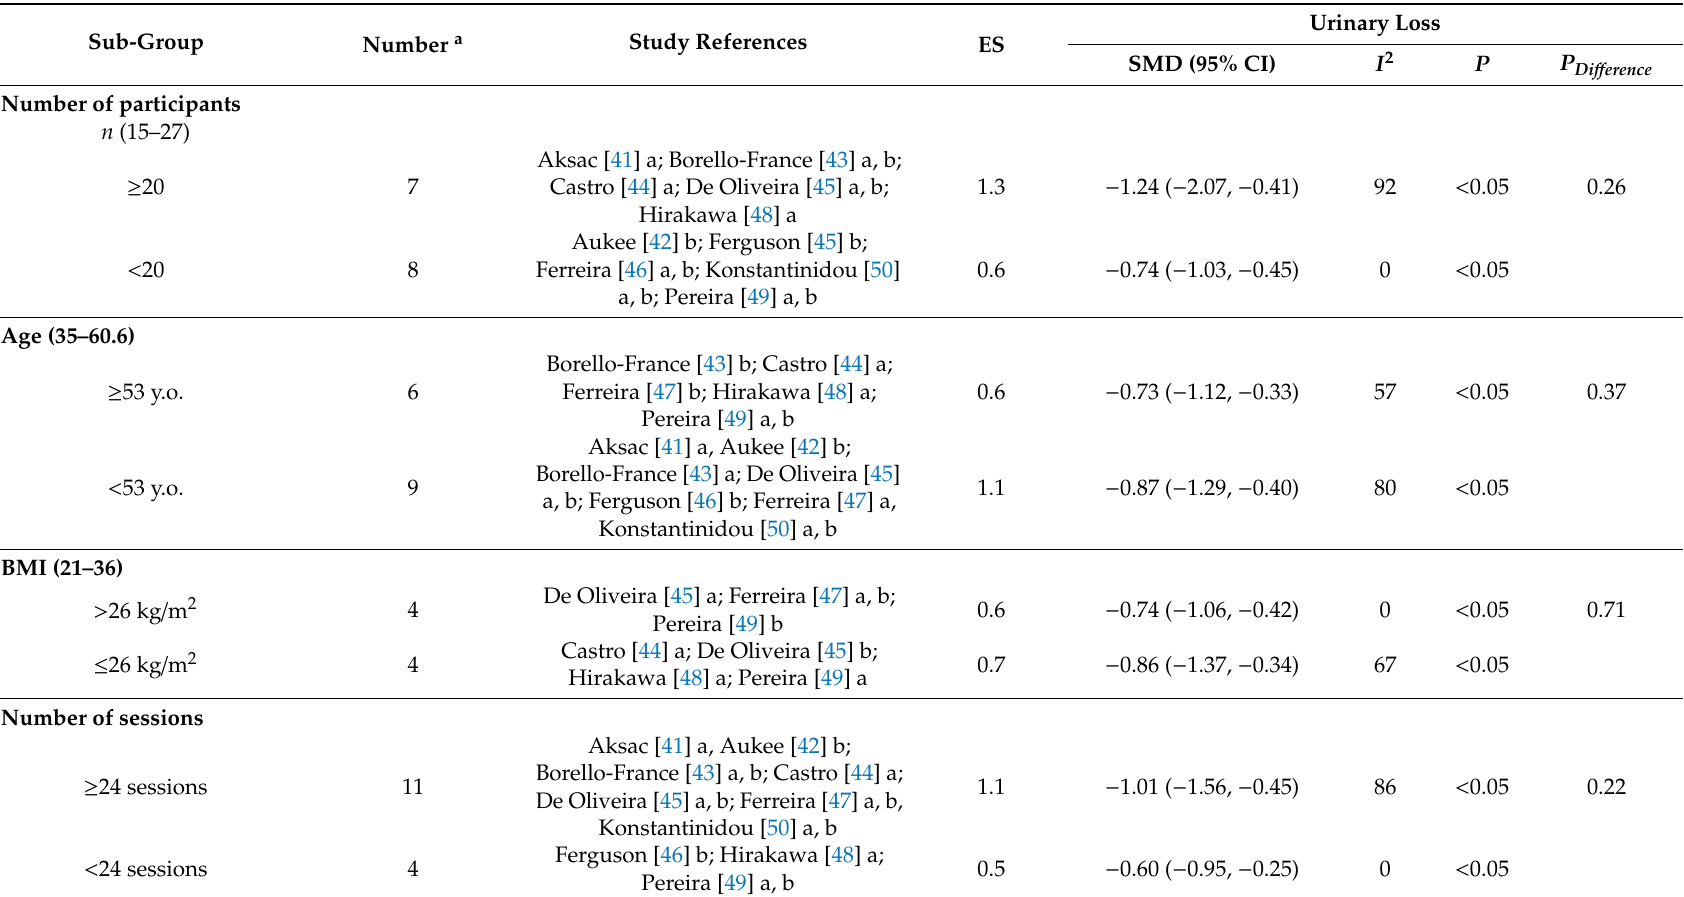
Table 3. Subgroup analyses assessing potential moderating factors for urinary loss in PFT studies included in the